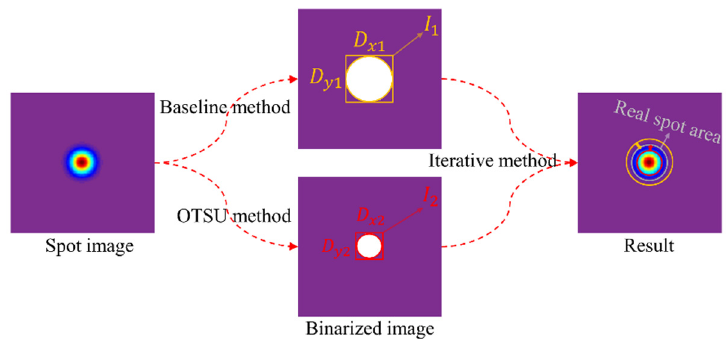
Figure 4. Center location method of laser spot area shrinking iteration.